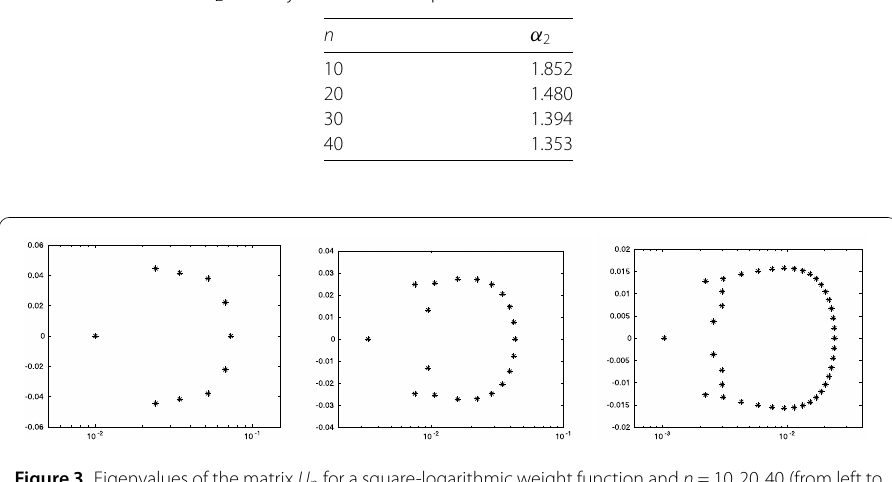
Table 3 The values of α 2 in Conjecture 5.4 in dependence of n